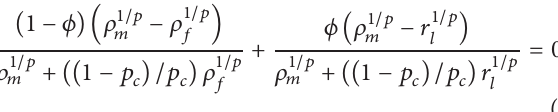
Figure 12: DC electrical conductivity of the nanocomposite when the percolation threshold of the filler is varied (McLachlan’s